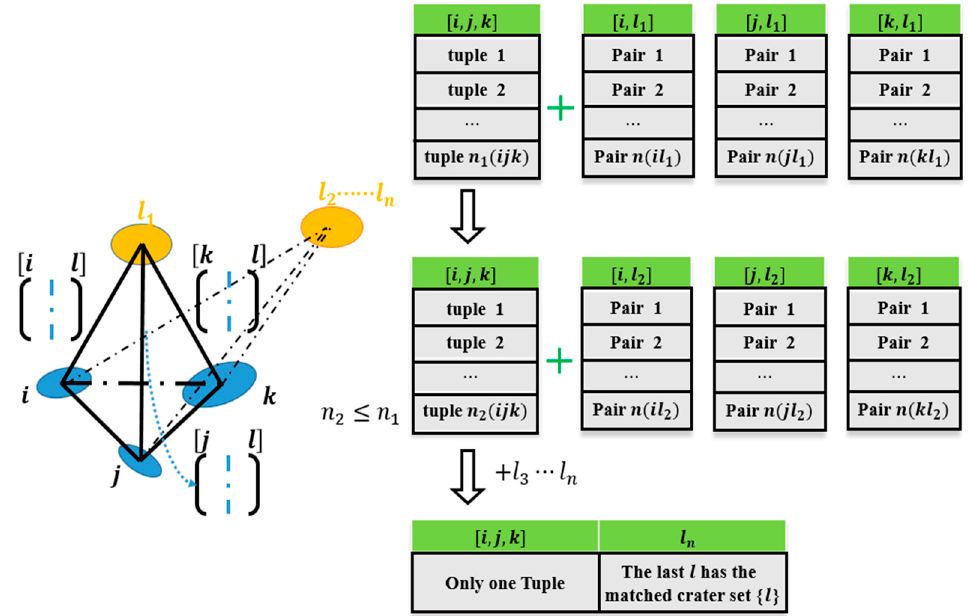
Figure 7. Fourth crater 𝑙 is added, forming a pyramid to remove redundant tuples. If the set is reduced to only one tuple, the last matched crater set {𝑙} is reserved.